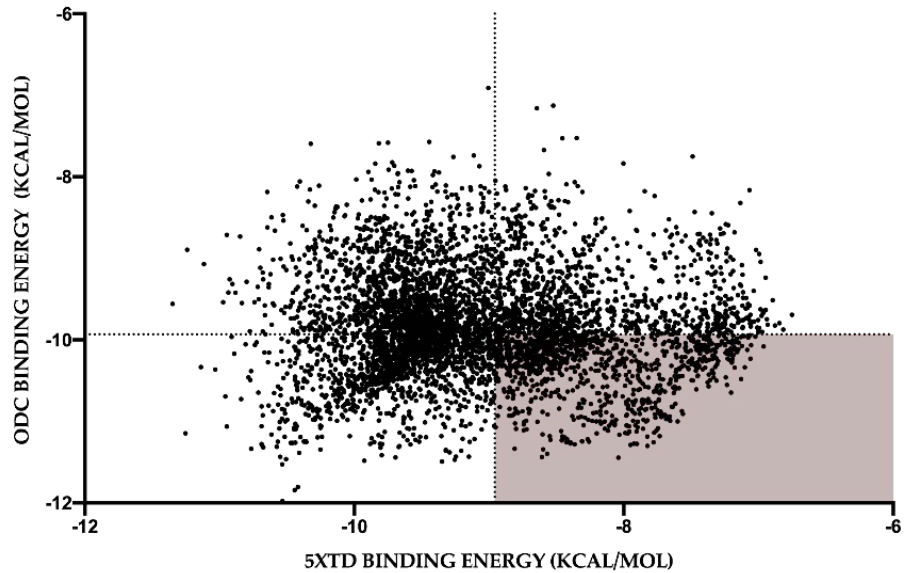
Figure 7. Energy binding of the 5859 cured molecules deguelin derivatives against human NUO (5XTD) and L. amazonensis ODC. Each point represents a single molecule. Lines represent the basal value for deguelin in both targets. In red area are highlighted those molecules with better parameters, i.e., those that improve their affinity for Leishmania ODC while decreasing their affinity for human NUO.